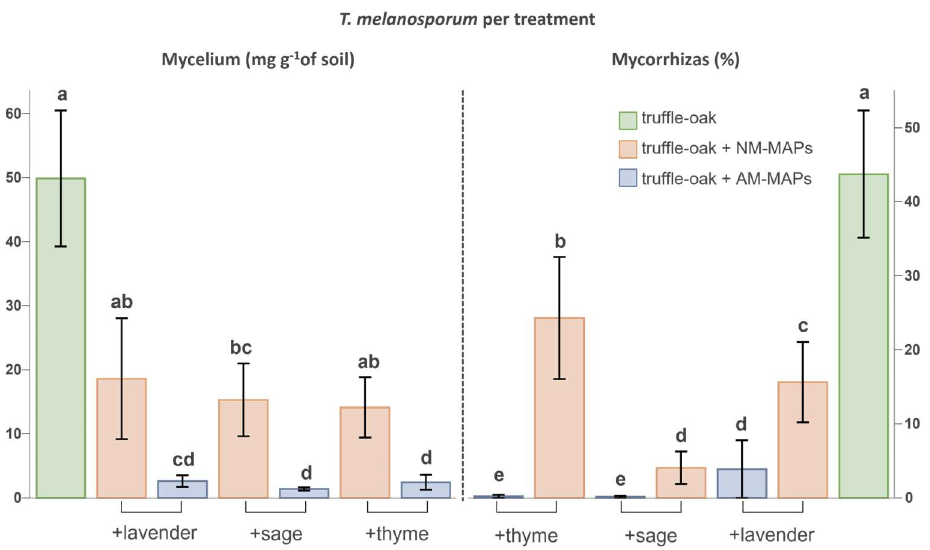
Figure 3. Tuber melanosporum extraradical mycelium biomass (graph on the left) and truffle ectomy- corrhizal percentages of oaks (graph on the right). Truffle-oaks were growing alone ( n = 7) or in presence of MAPs, either non-inoculated (NM, n = 7 per species) or inoculated (AM, n = 7 per species) with native AMF. Data include means and standard errors. Mycelium biomass was analyzed by one-way ANOVA (F (6,42) = 12.65, p < 0.0001) and the percentages of ectomycorrhizas by generalized linear models (Chi-Square (6,42) = 1466, p < 0.0001) assuming a binomial distribution of colonized vs. non-colonized roots. In each graph, treatments sharing the same lowercase letter are not significantly different (Tukey’s test, p < 0.05).